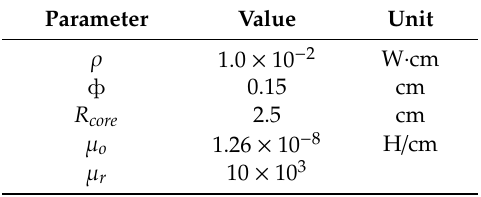
Table 2. Parameters of the inductance model for power and efficiency analysis.